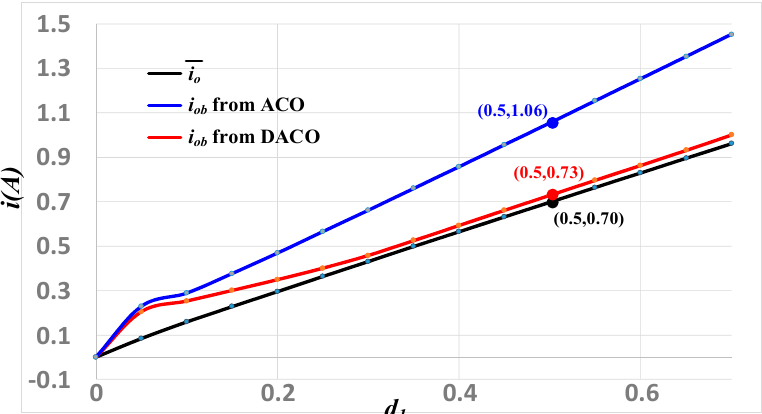
Figure 15. Comparison among the measured output current average value, the observed current from ACO and the observed current from DACO.